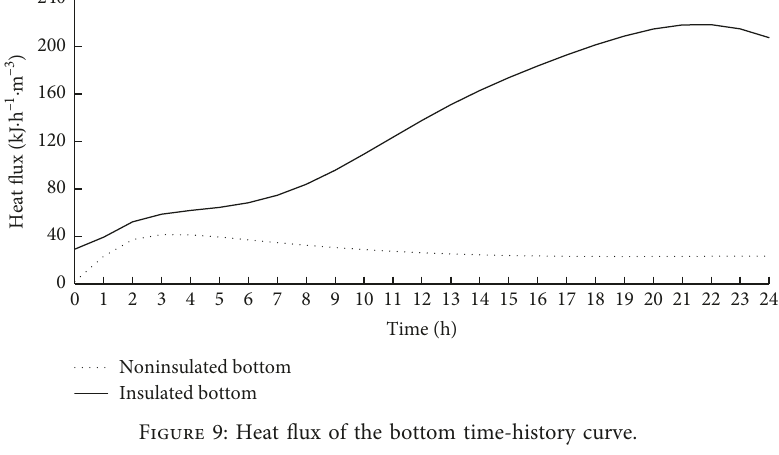
Figure 9: Heat flux of the bottom time-history curve.